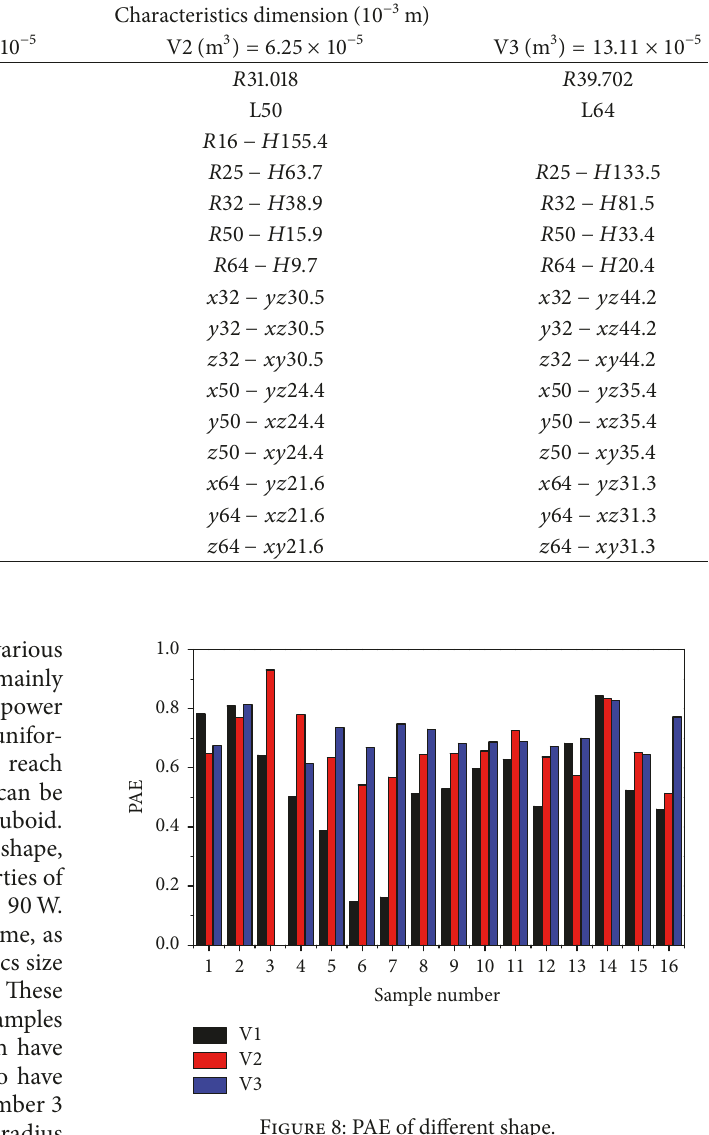
between spherical and cubic samples on power absorption capability and temperature distribution uniformity mainly originate from the focusing tendency of microwave at the samples’ corners and were concluded in the two-dimension simulation of reference [37] and can be also seen in the result diagram of cubic sample in Figure 3. Further comparison between spherical and cubic samples will be discussed in Section